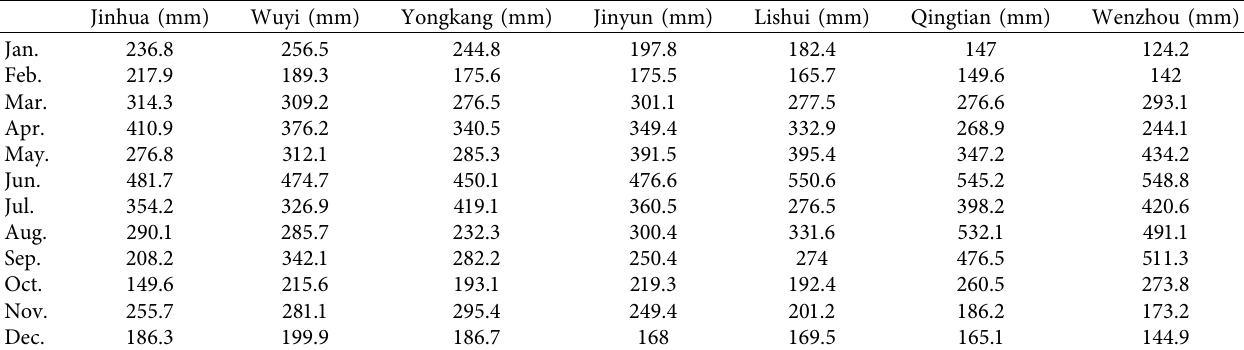
Table 6: Monthly distribution of average rainfall of Wenli